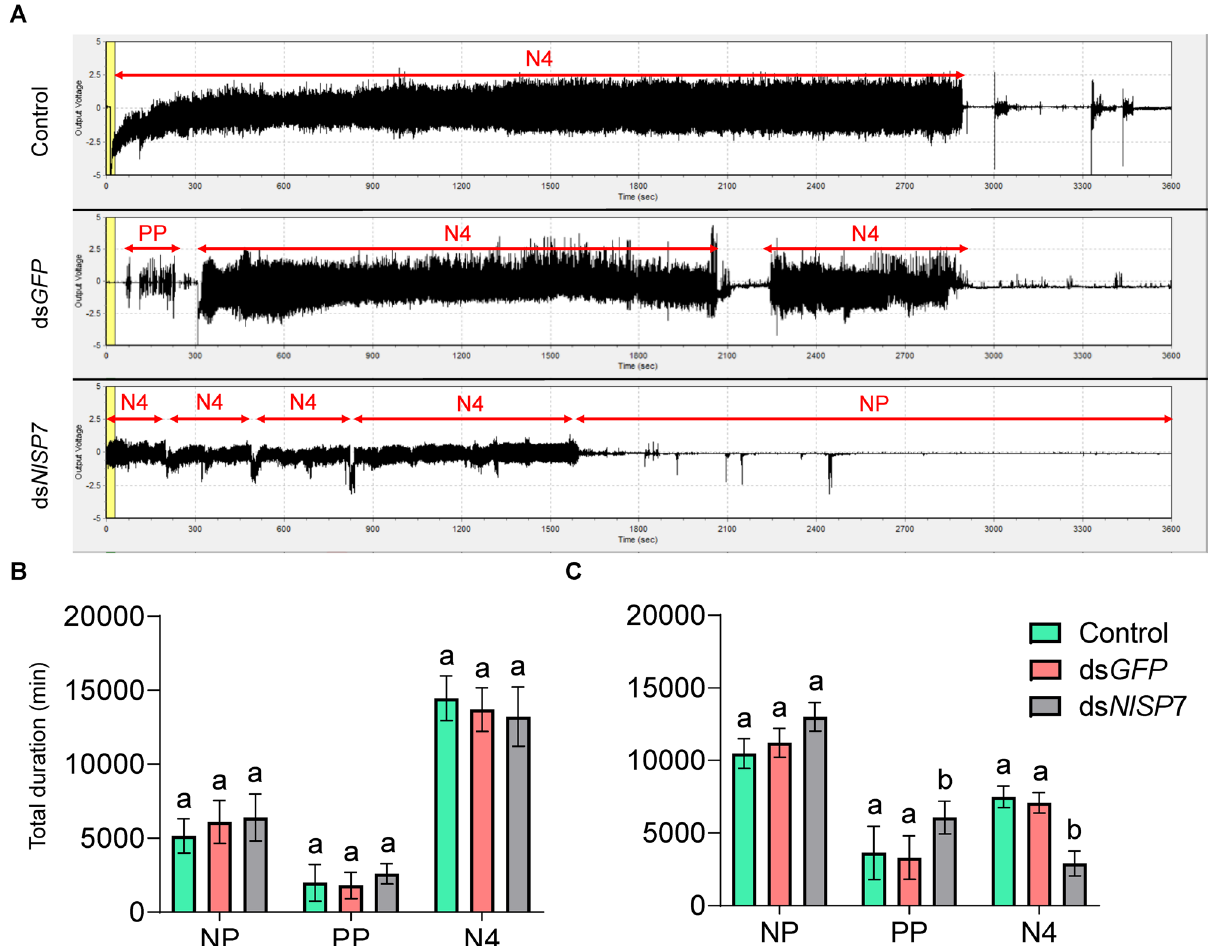
Figure 5. Brown planthoppers in three groups (the order is control, injected with ds GFP , injected with ds NlSP7 ) exhibit reduced feeding on two artificial diets (0 mg/l tricin and 100 mg/l tricin). ( A ) Overall typical view of electrical penetration graph waveforms generated by the feeding behavior of brown planthoppers on artificial diets. ( B , C ) data collected from 1-day-old brachypterous female adults with different treatments. NP, nonpenetration; PP, pathway phase (N1 + N2 + N3), including penetration initiation (N1), salivation and stylet movement (N2), and extracellular activity near the phloem (N3); N4, sucrose or tricin solution ingestion. B the duration of each wavelength when feeding on artificial diets without tricin (0 mg/l) and C artificial diets with tricin (100 mg/l) is shown. Electrical penetration graph data were recorded for 6 h per insect. Different letters indicate significant differences among the three treatment groups. Testing of each group was repeated 15 times ( P < 0.01, Duncan’s multiple range